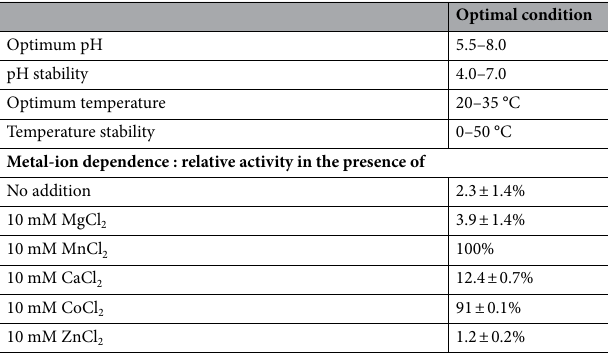
Table 2. Enzyme properties of recombinant BmGalNAcT expressed in Sf9 cells. The relative activities in metal-ion dependency were calculated on the basis of the presence of Mn 2+